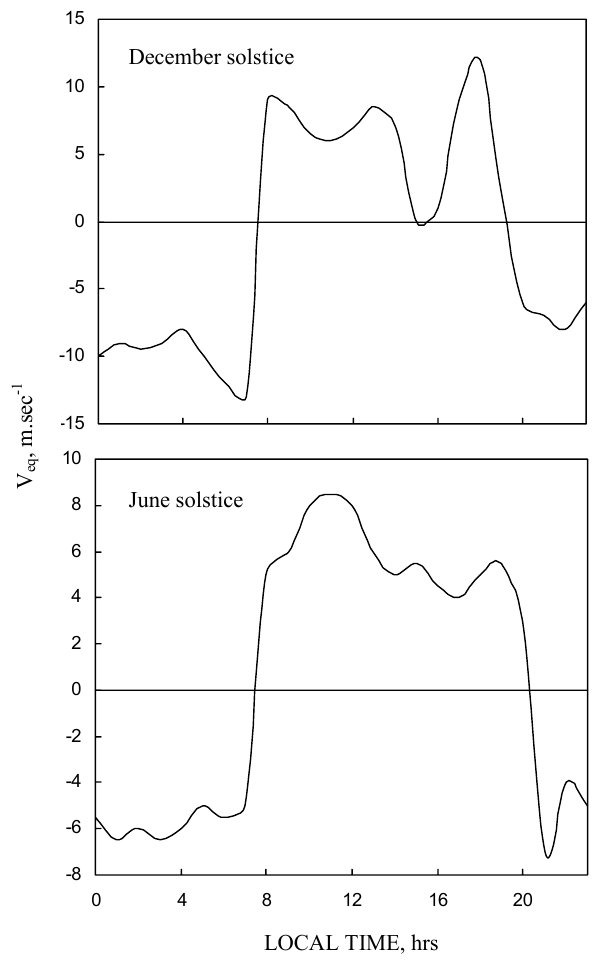
Fig. 2. Local time variation of equatorial vertical E × B drift veloc- ity in December (top) and June solstice (bottom) over